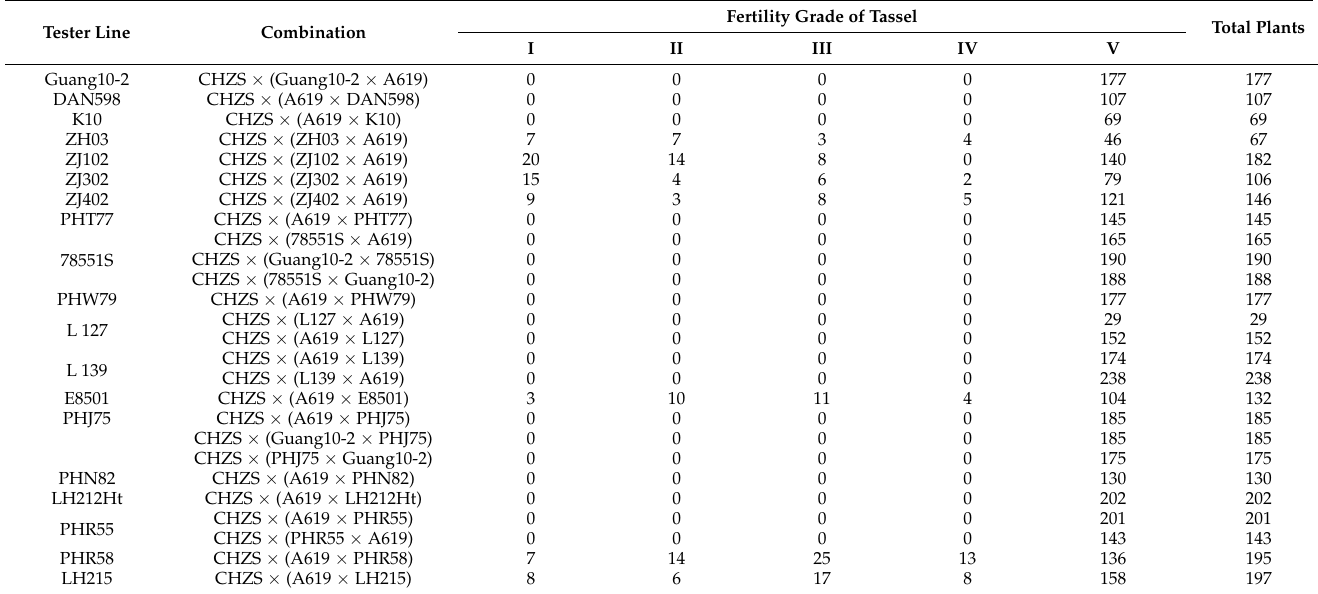
Table 6. The segregation of fertility in BC 1 populations derived from the cross between the CHZS, A619, and tester lines.